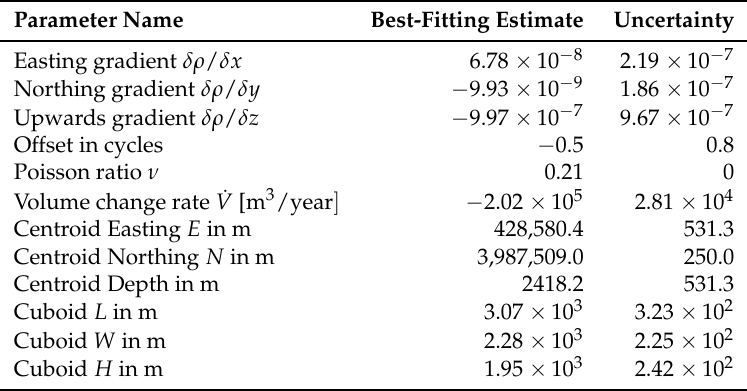
Table 2. Results from nonlinear inversion with a “cuboid” parameterization on the stack of MST Envisat pairs spanning 2004 to